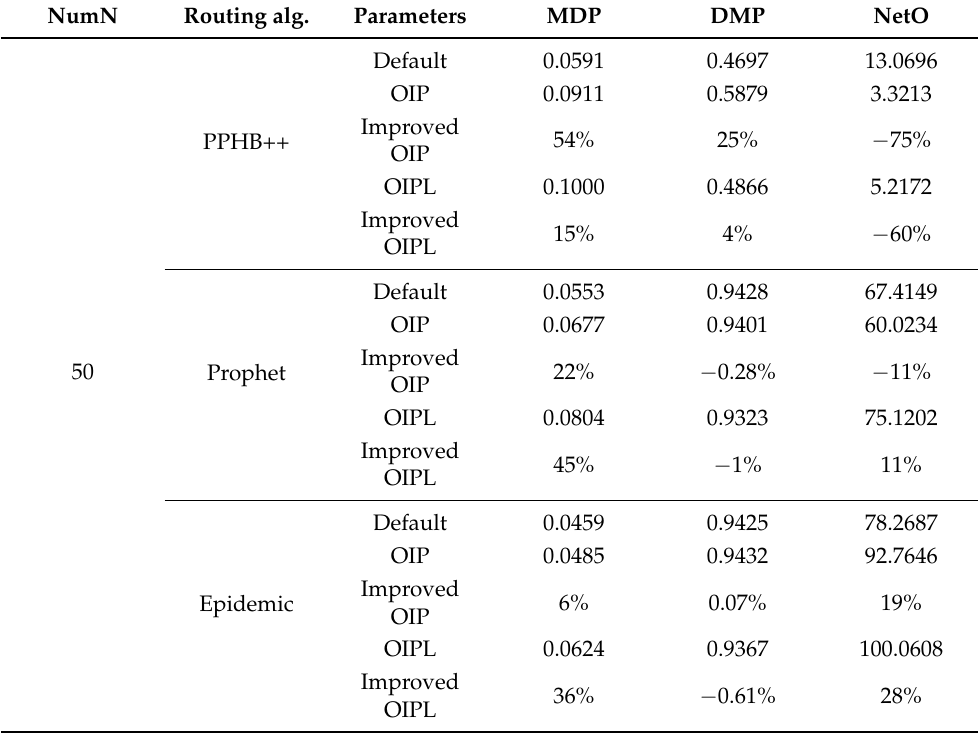
Table A2. Comparison of ONE default setting with optimized parameters for Rome